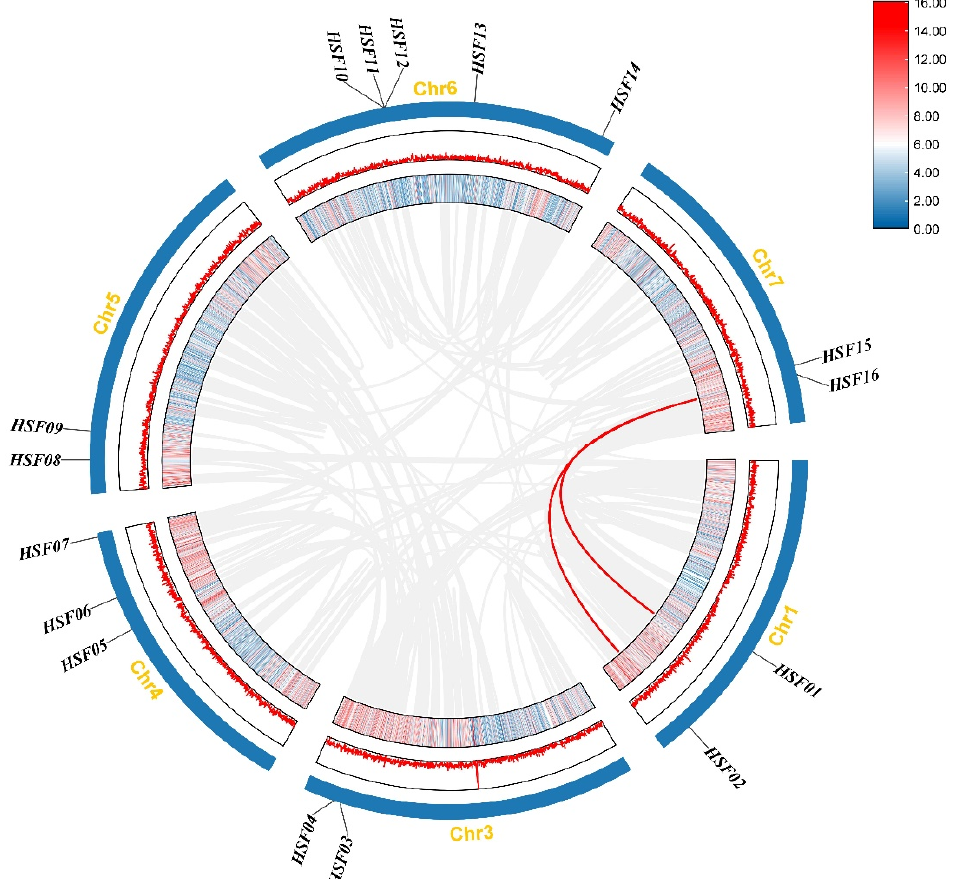
Figure 6. Chromosome distribution and interchromosomal relationships of MsHSF genes. Gray lines indicate synthetic blocks within the M. sativa genome, and red lines indicate duplicated MsHSF gene pairs.